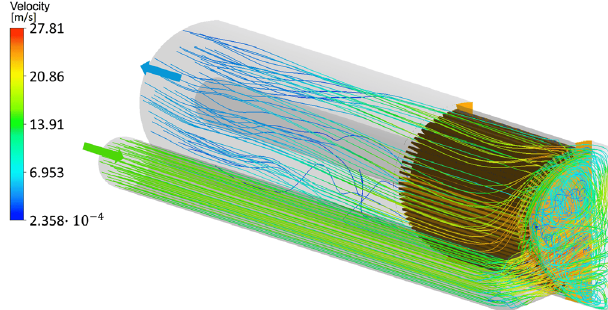
isolated.FIG. 10. Velocity streamlines obtained for the steady state CFD simulation that computes the impact of the 2 GeV NORMGPS beam with an intensity of 1 × 10 14 ppp and a 50% dumping rate (the nominal operation for which the dump was